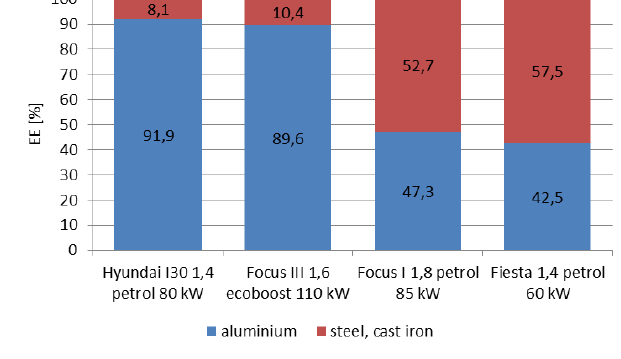
Fig. 2. Percentage of energy expenditure